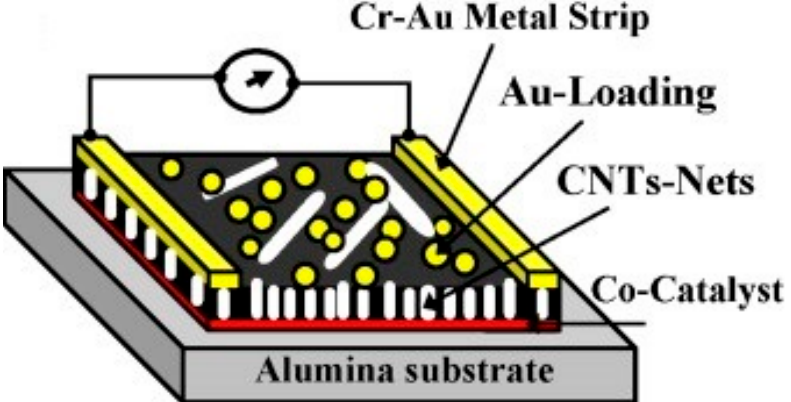
Figure 5. Schematic of the two-pole chemiresistor based on CNTs networks, grown by radiofre- quency plasma-enhanced chemical vapour deposition onto alumina substrate coated with cobalt (Co) catalysts, surface-functionalised with Au nanoclusters. Reproduced with permission from [180]. Copyright © 2021 Elsevier B.V. All rights